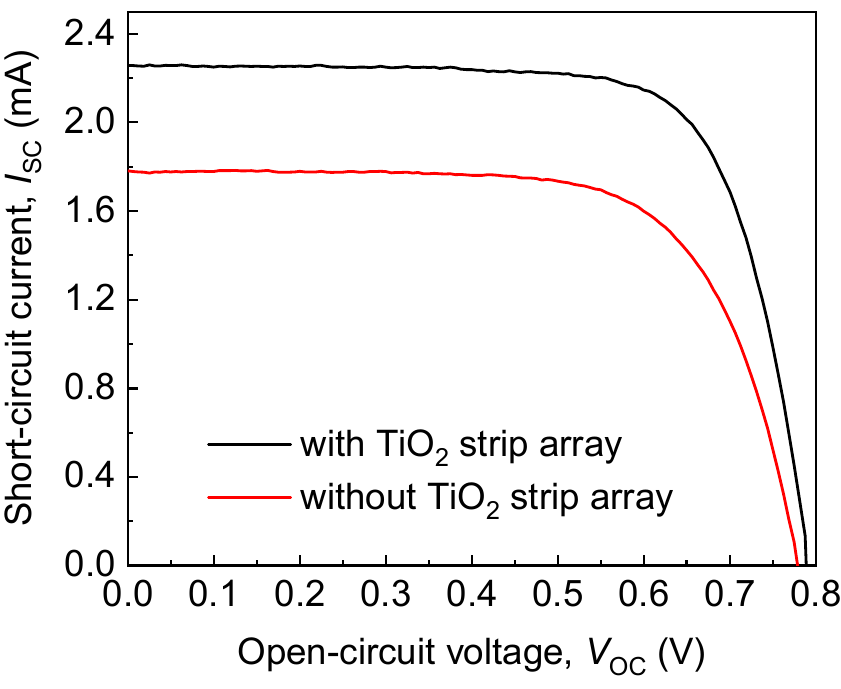
Figure 5. Dependences of short-circuit currents ( I SC ) of DSSCs with and without TiO 2 strip array on open-circuit voltages ( V OC ). Table 1. Averaged photovoltaic parameters of DSSCs with and without the TiO 2 strip